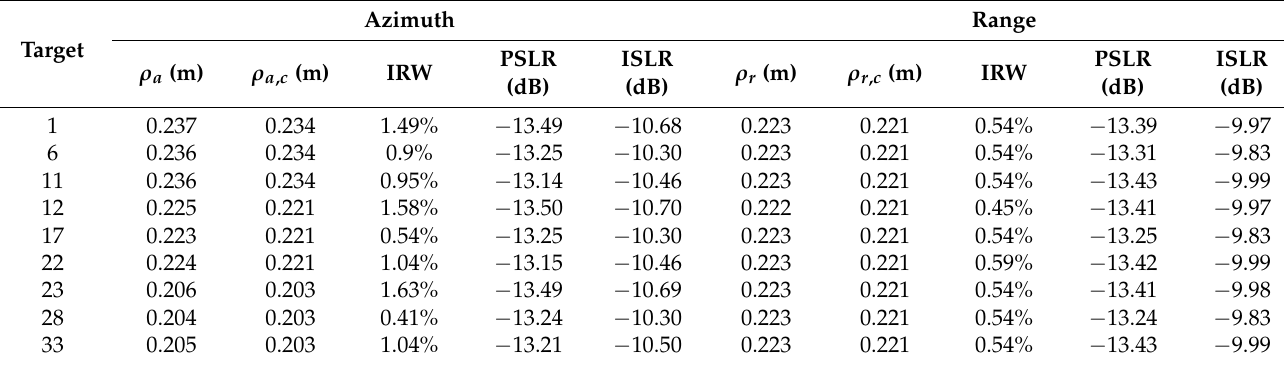
Table 4. The evaluation results of nine targets.